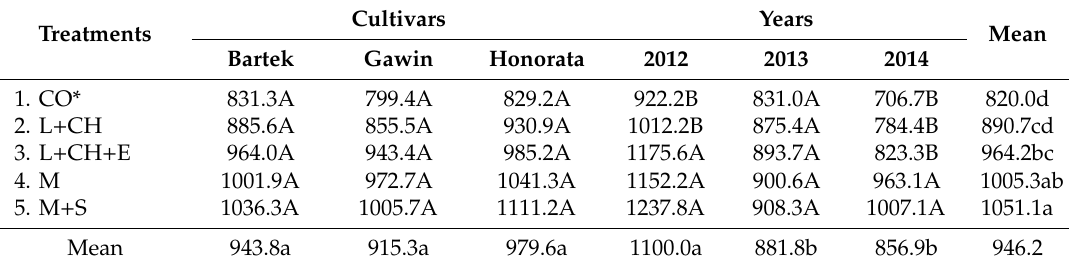
Table 8. Tuber weight per one potato plant